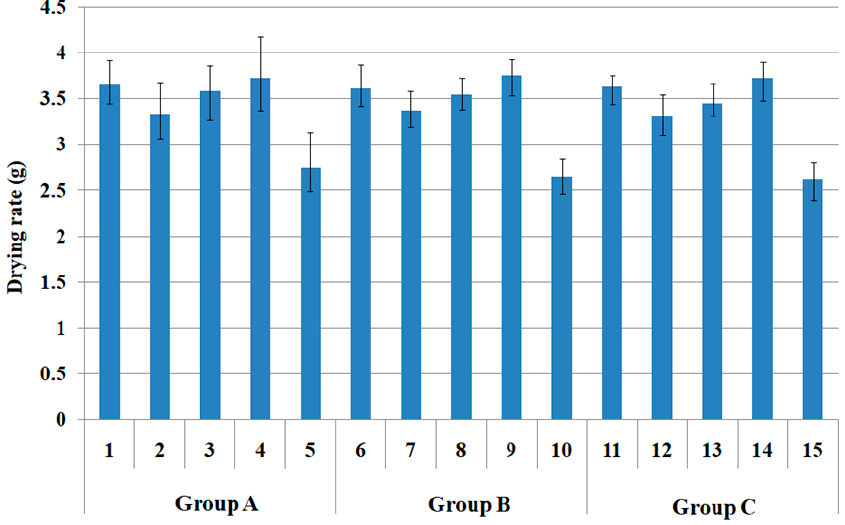
Figure 6. Drying rate at a transient state of each fabric group ( p < 0.05).